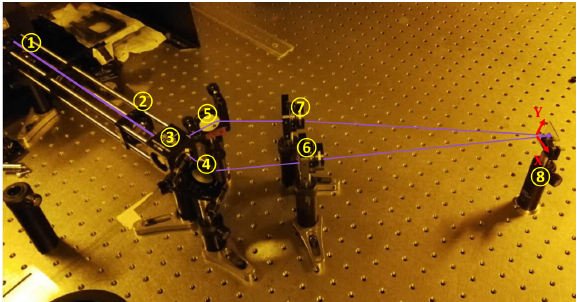
Figure 2. Procedure to fabricate a photoaligned LC geometric phase grating.